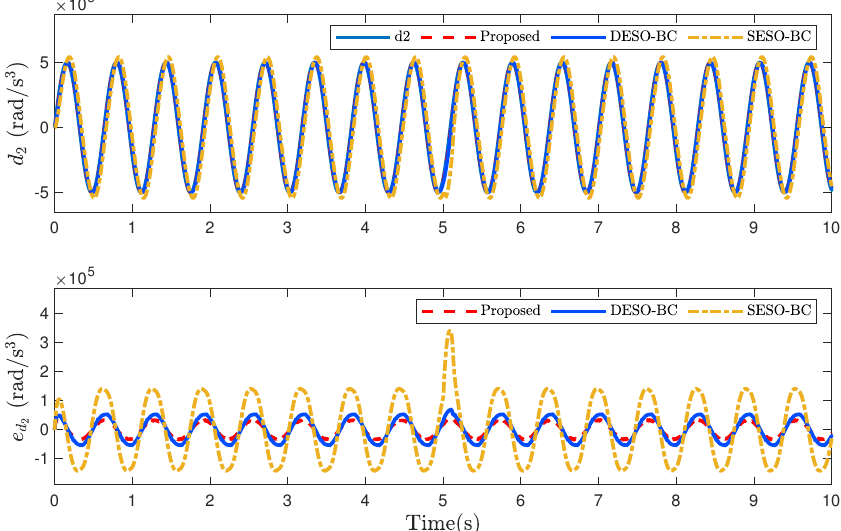
Figure 10. Lumped matched uncertainty estimation performances of all control approaches in case of step reference